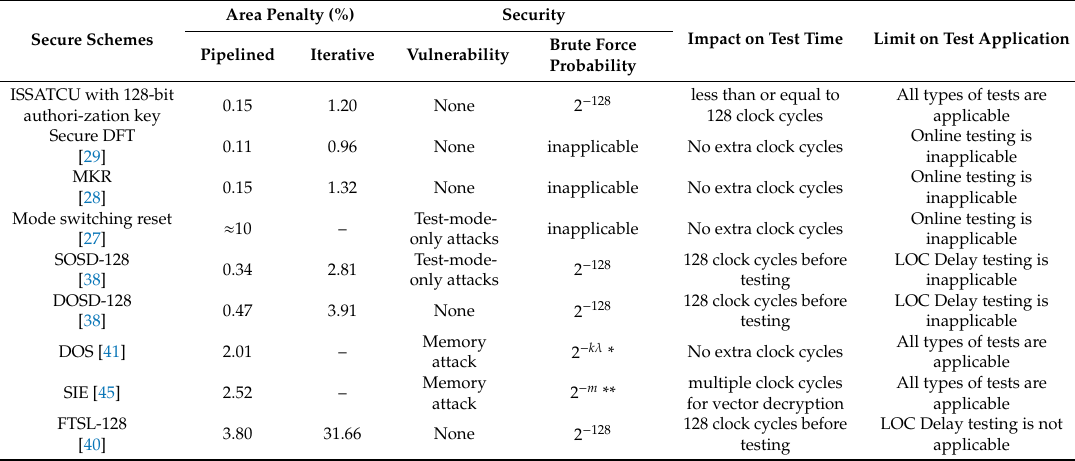
Table 3. Comparison of di ff erent security